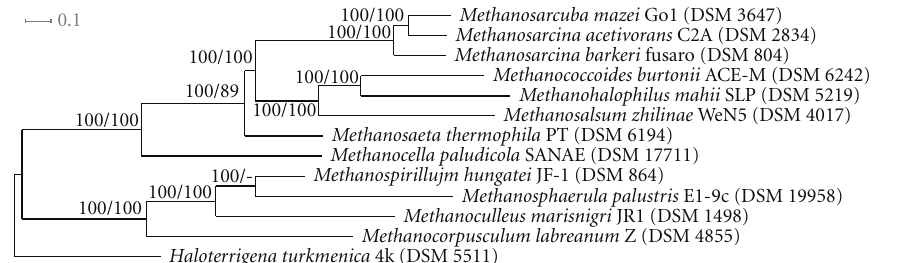
Figure 3: Maximum likelihood (ML) phylogenetic tree inferred from the 2344-gene supermatrix. The branches are scaled in terms of the expected number of substitutions per site. Numbers above branches are support values from ML (left) and maximum parsimony (MP; right) bootstrapping. The tree was rooted with the Haloterrigena turkmenica genome [19] included in the sample. The topology of the single best MP tree was identical to the one depicted here except for the unsupported branch connecting Methanosphaerula palustris and Methanospirillum hungatei